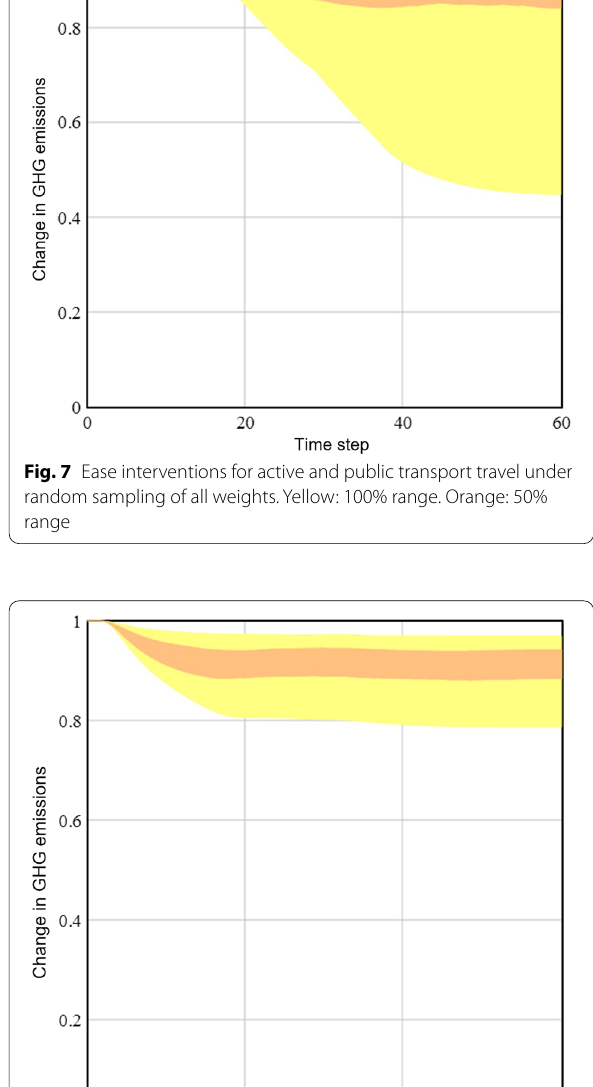
Fig. 8 Cost interventions for car and public transport travel under random sampling of all weights. Yellow: 100% range. Orange: 50%